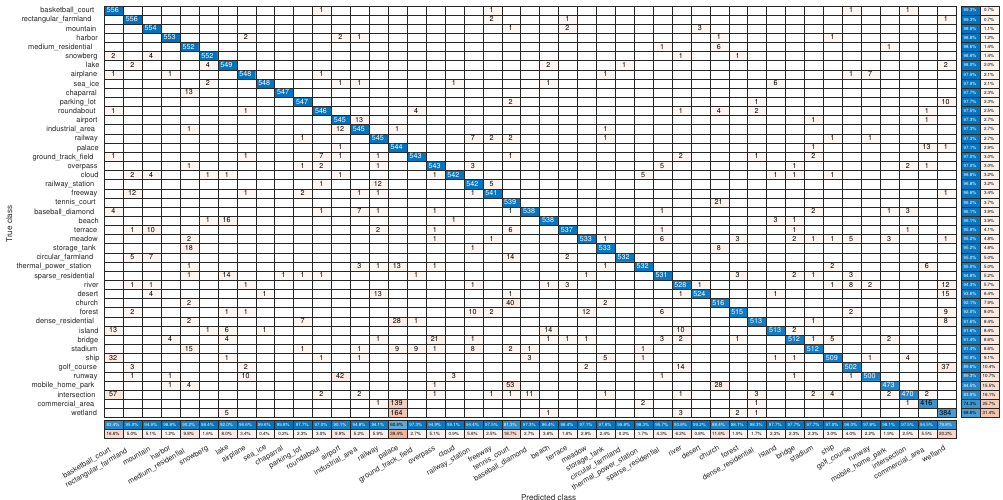
Figure 5. Confusion matrix of the proposed FDPResNet on NWPU-RESISC45